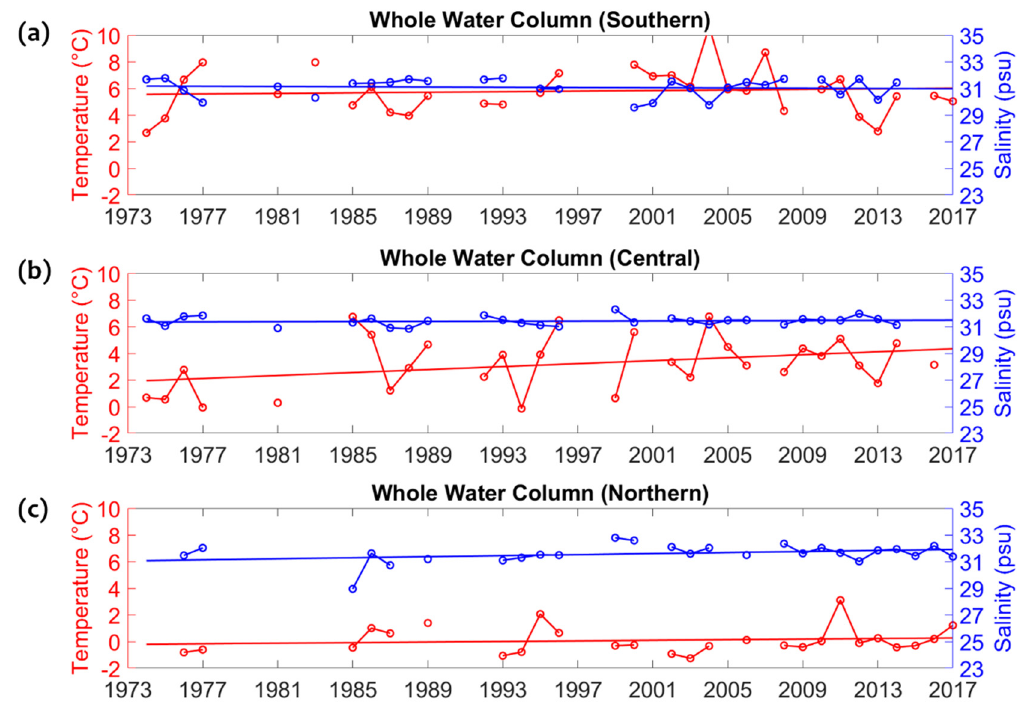
Figure 5. Time series for the entire water column in the ( a ) southern, ( b ) central, and ( c ) northern Chukchi Sea. Table 1. The trends ( ◦ C · year − 1 for temperature (T); psu year − 1 for salinity (S)) and their p -values of the temperature and salinity of the whole water column, surface and bottom in the southern, central and northern Chukchi Sea. The values in bold represent the corresponding trends with confidence levels above 95%. Southern